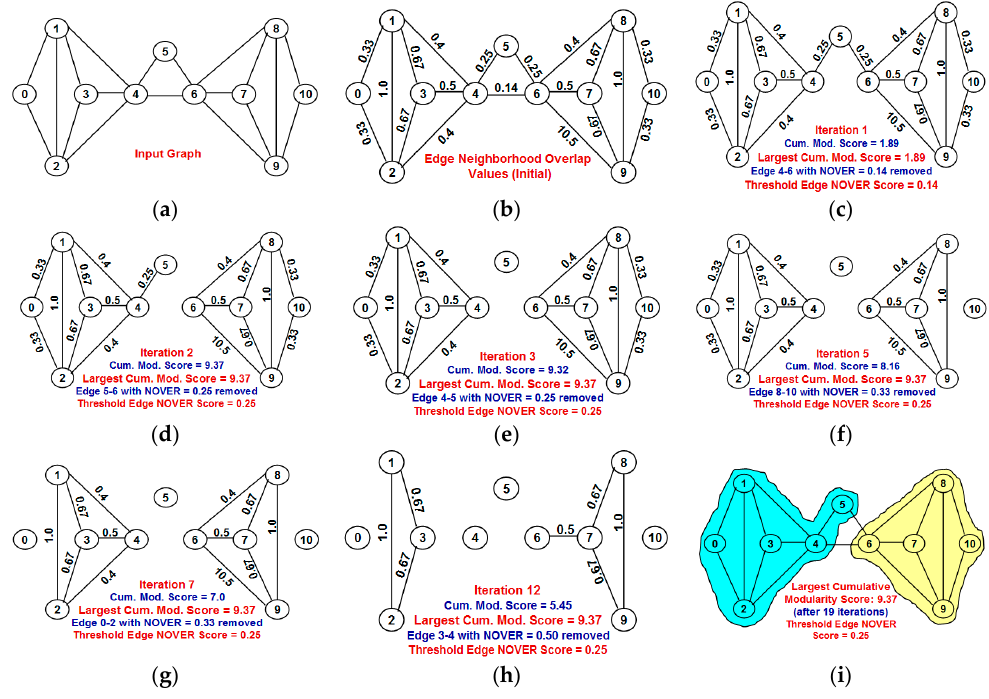
Figure 4. Example to illustrate the execution of the NOVER algorithm. ( a ) Input